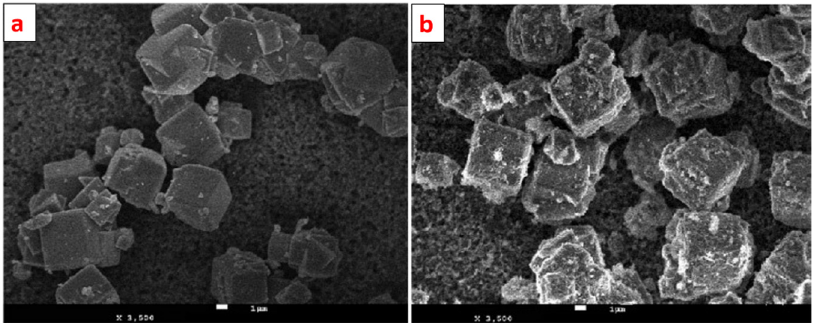
Figure 15. FE-SEM images of ( a ) zeolite and ( b ) ZnO nanoparticle-doped zeolite. Reprinted from Ref. [101].